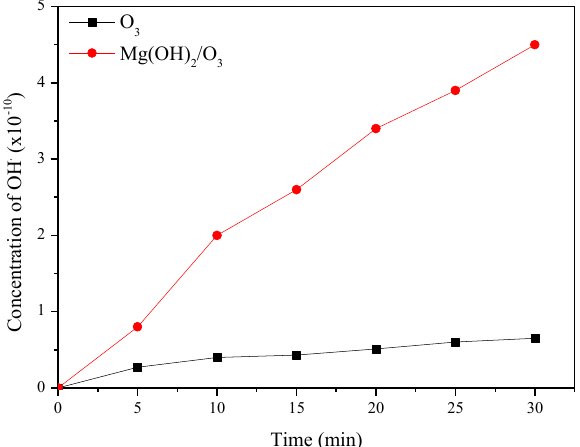
Figure 5. The concentration of OH . produced during ozonation and catalytic ozonation.